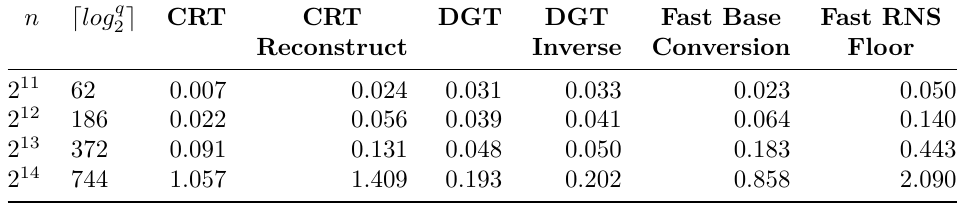
Table 6: Latency in (millisecond) of core compute kernels on NVIDIA Tesla K80.